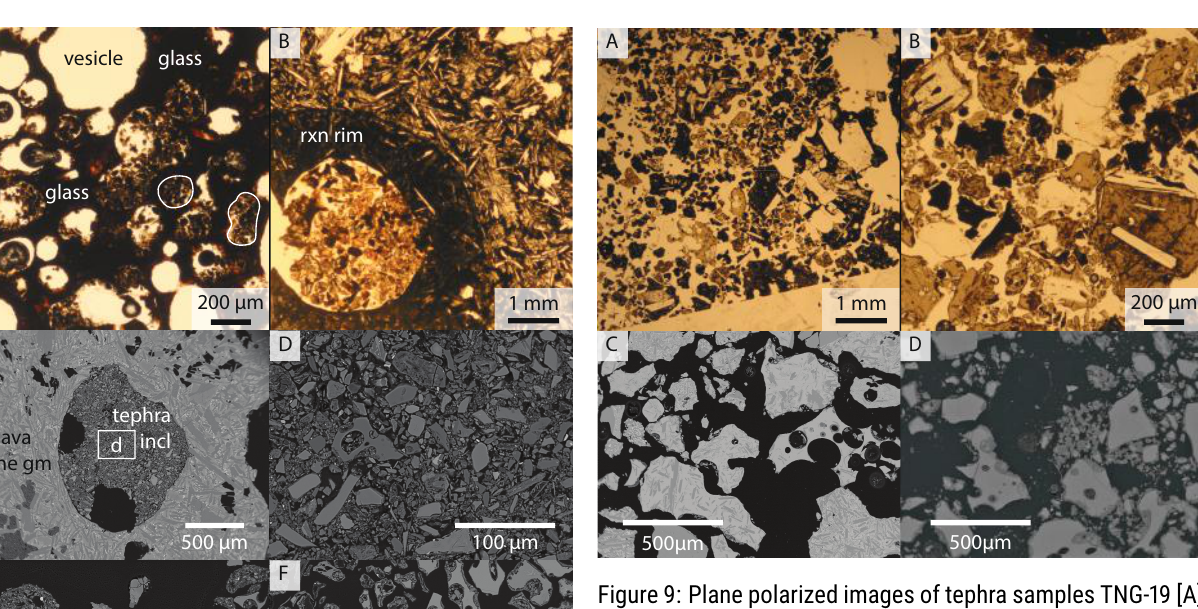
zation than the hyaloclastite.